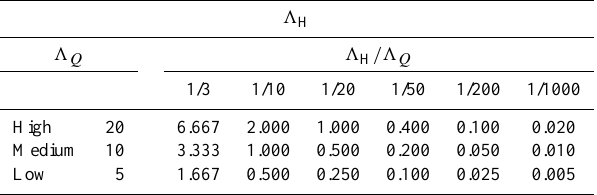
Table 4. Values of dimensionless ratios φ/I A (for 3 p =21) and W A /I A , based on different values of 3 q and 3 H /3 q